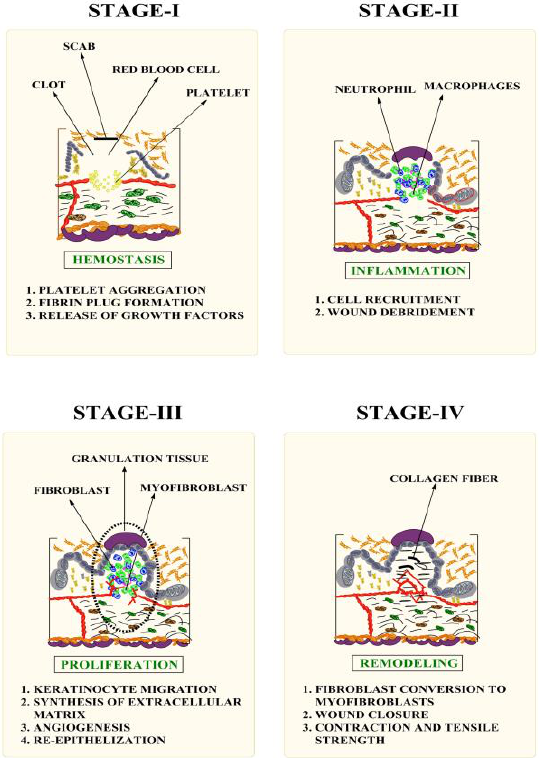
Figure 1. Various stages of the wound-healing mechanism. A wound dressing’s primary function, in addition to acting as a protective covering (shielding the wound), is to expedite the healing process [26]. Until the